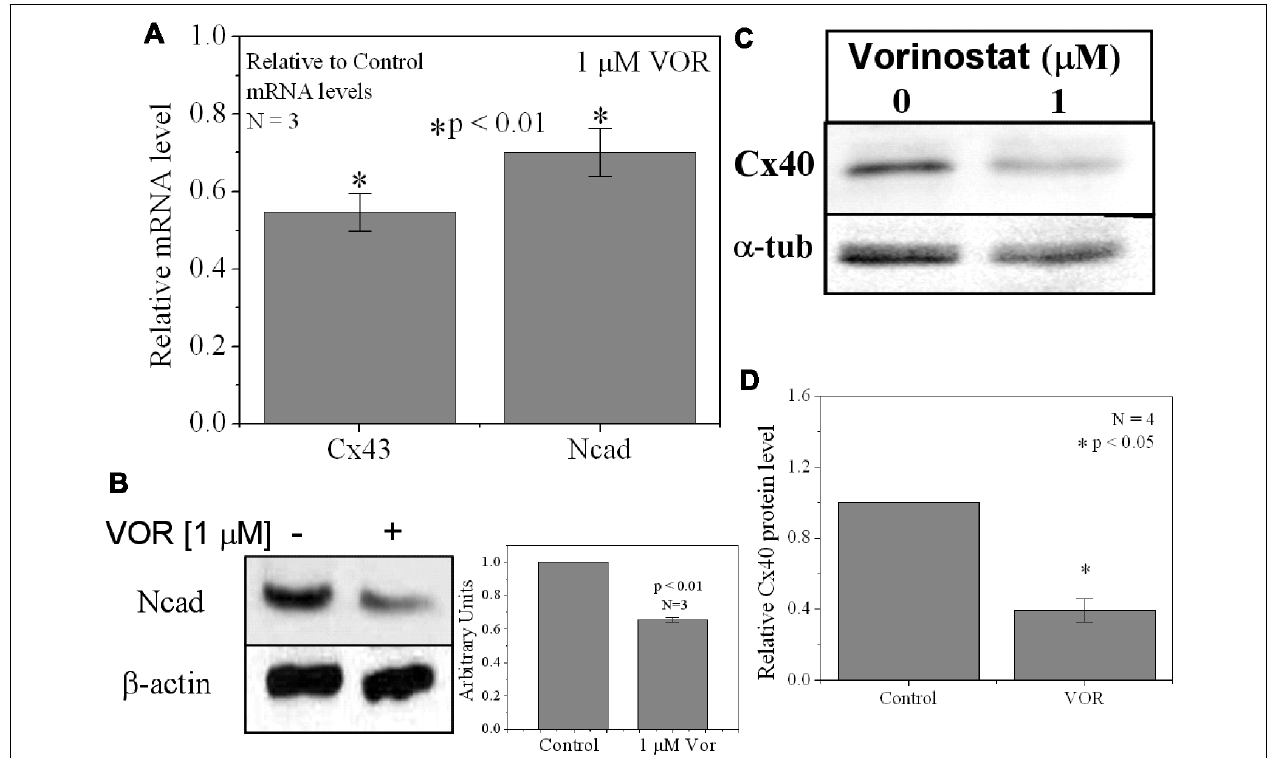
FIGURE 3 | Reduction of Cx40 and N-cadherin expression by HDACI. (A) Overnight (18 h) treatment with 1 μ MVOR significantly reduced Cx43 and N-cadherin mRNA levels by 45 ± 5 and 30 ± 6%, respectively. Experimental mean values were statistically different from control values ( p -value < 0.05, one-way ANOVA). (B) Immunoblots were also performed for Ncad and β -actin (internal control).Total Ncad levels from three experiments were decreased by 1 μ MVOR relative to control (untreated)